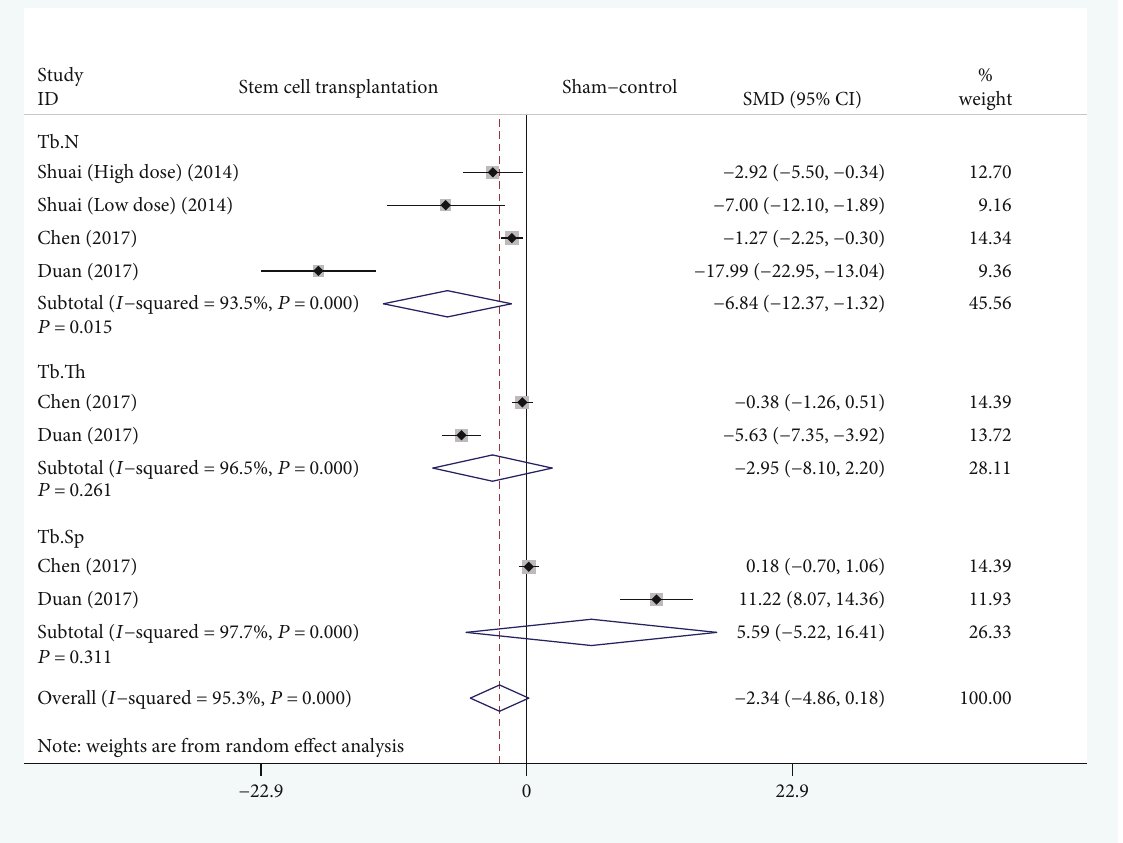
Figure 8: Forest plot showing the e ff ect of the BMSC transplantation group compared with the sham operation group on Tb.N, Tb.Th, and Tb.Sp. Tb.N: trabecular number; Tb.Th: trabecular thickness; Tb.Sp: trabecular